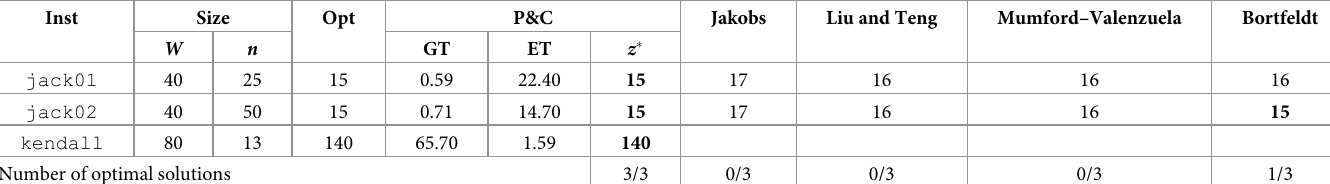
Table 2. Results for jack and kendall instances.